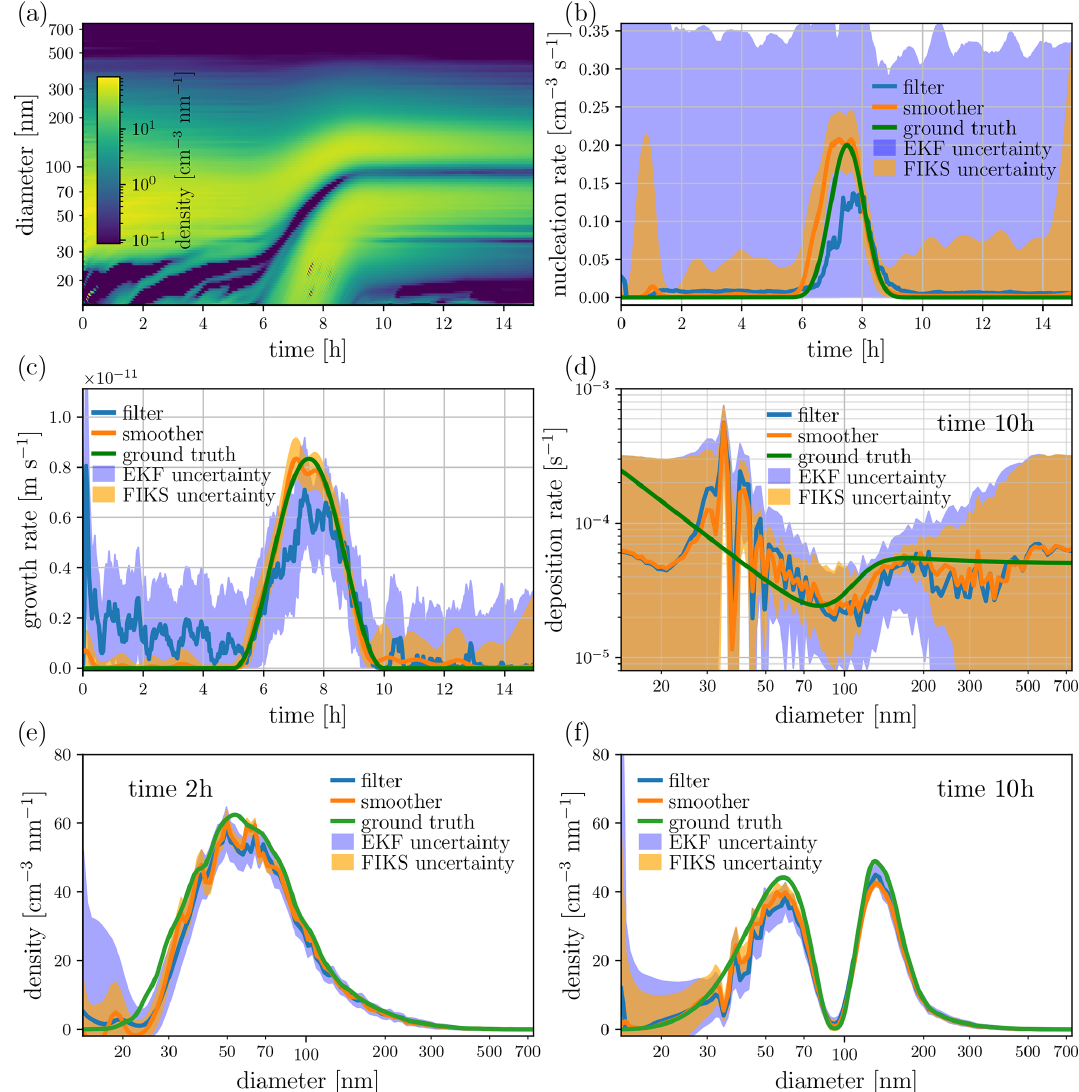
Figure 4. Case 2 – NE and low SNR. State estimates for the particle size density (a, e, f) , nucleation rate (b) , growth rate (c) and loss rate (d) . The image in plot (a) depicts the approximate posterior expectation for the entire time-evolution of the particle size density given by FIKS, whereas plots ( e ) and ( f ) illustrate the EKF and FIKS estimates corresponding to times 2 and 10h, respectively. In plots (b) – (f) , the blue and orange lines represent the approximate posterior expectations for EKF and FIKS, respectively, and the areas shaded with light blue and orange are the respective posterior error intervals. The true values of the corresponding quantities are drawn with a green